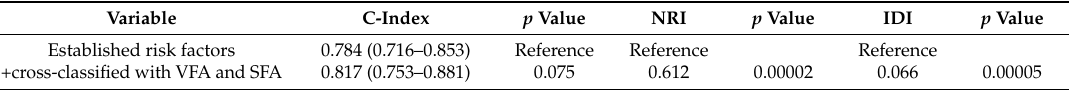
Table 4. Predictive value of the abdominal fat levels for all-cause mortality using the C-index, net reclassification improvement (NRI), and integrated discrimination improvement